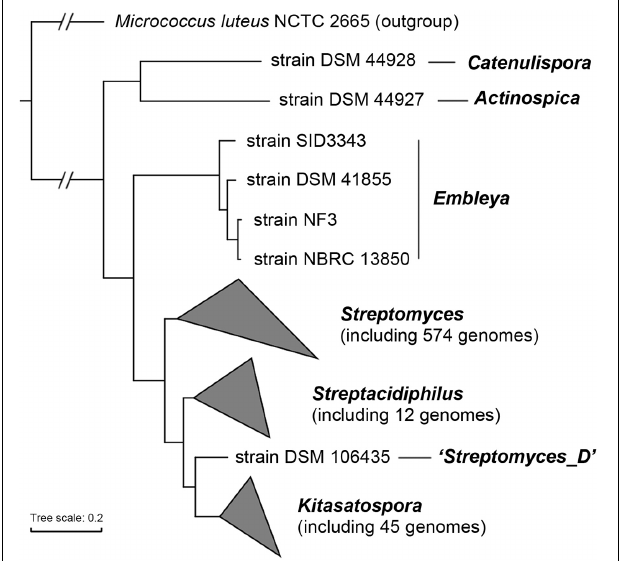
FIGURE 1 | Phylogenomic tree of the family Streptomycetaceae . The tree was constructed based on 138 single-copy actinobacterial marker genes. Taxonomy of each strain was derived from GTDB. All nodes have 100% bootstrap support. The scale bar indicates 20% sequence